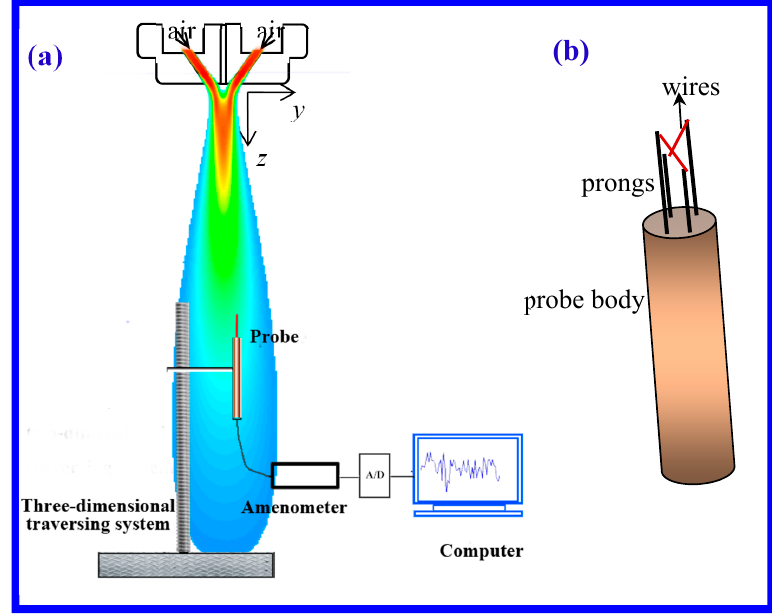
Figure 4. ( a ) Schematic of the constant temperature anemometer (CTA) device and melt-blown die during air velocity direction measurement. The shown air flow field is obtained by Computational Fluid Dynamics (CFD). ( b ) The structures of the dual-wire probe.